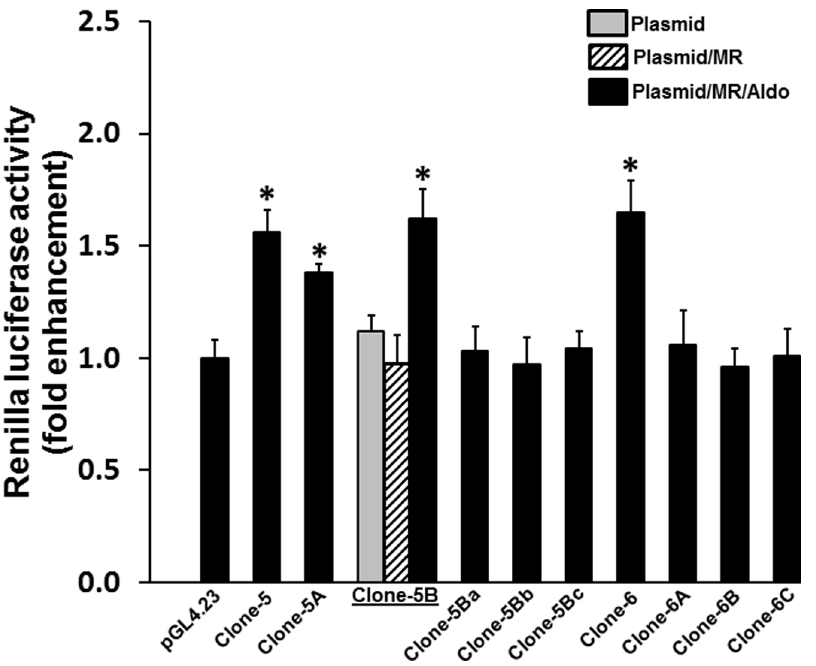
Figure 6. Sub-localization of mineralocorticoid response elements (MRE) in clone-5 and clone-6. The clone-5 was sub-cloned into thirds, clone-5A, clone-5B and clone-5C representing the left, middle and right thirds of clone-5, respectively. Clone-5A, -5B and -5C were tested for MRE/ aldosterone responsiveness in the HEK293T cells. The HEK293T cells transfected with clone-5A and clone-5B exhibited a significantly higher luciferase activity compared to the pGL4.23 vector transfected cells. Neither clone-5A nor clone-5B contained candidate MREs as analyzed using the Transcription Element Search System (TESS) or MatInspector. Further sub-clones of clone-5B were made (clone-5Ba and clone-5Bb that represent the left and right half of clone-5B, respectively). (See Figure S1 for the sequences). Luciferase activity was not significantly altered in the HEK239T cells transfected with clone-5Ba and clone-5Bb, compared to the cells transfected with a vector (pGL4.23). Clone-6 was also sub-cloned into thirds (clone- 6A, clone-6B, and clone-6C). Similar to the clone-5Ba and clone-5Bb transfected cells, luciferase activity was also not significantly altered in the HECK293T cells transfected with clone-6A, clone-6B and clone-6C compared that of cells transfected with a vector (pGL4.23). Data presented represent mean 6 SE of triplicate assays of 3 different experiments. * p , 0.05– compared to